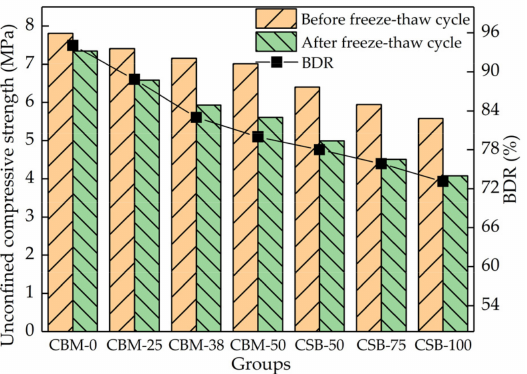
Figure 12. The unconfined compressive strength of mixture before and after F-T cycles.